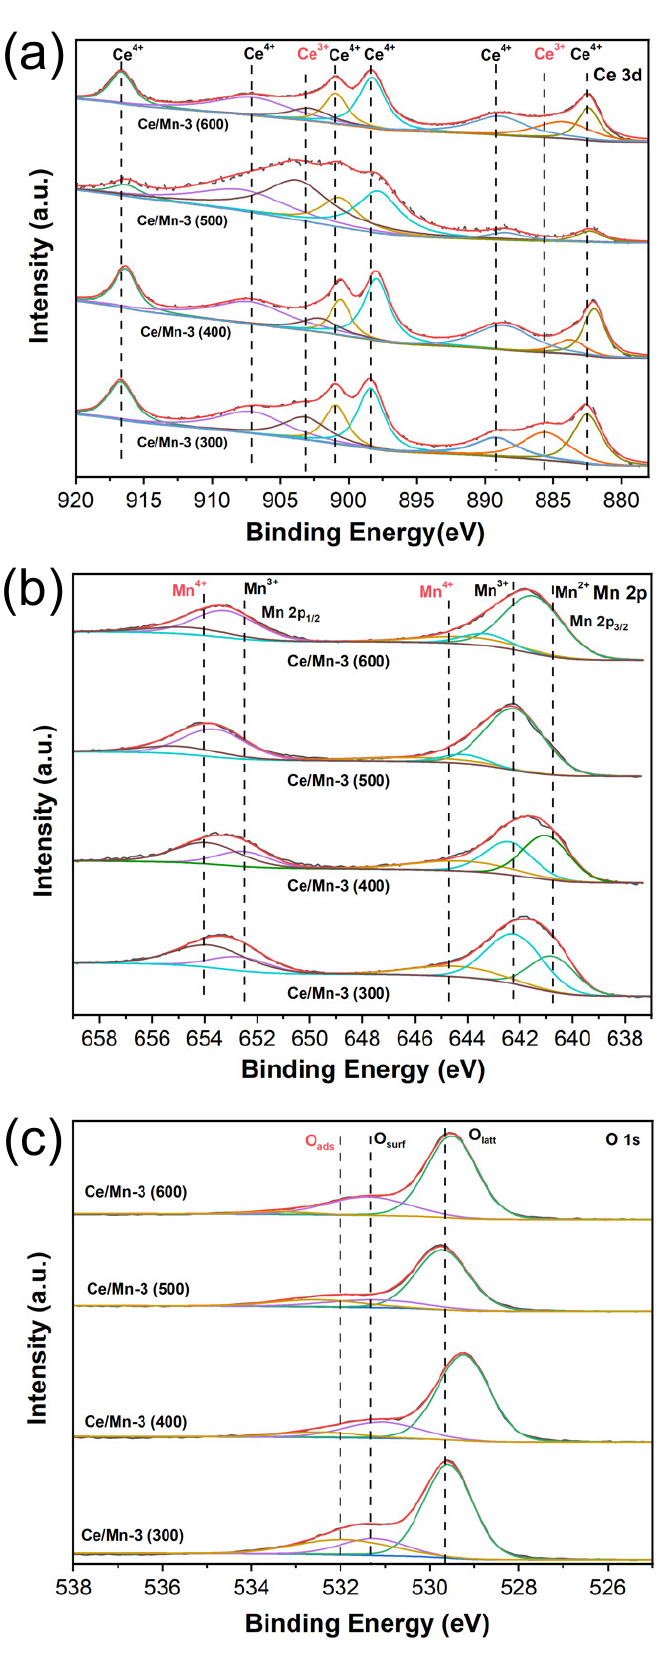
Figure 9. High-resolution XPS spectra of Ce/Mn-3 catalysts calcinated at different temperatures: ( a ) Ce 3d, ( b ) Mn 2p, and ( c ) O 1s.